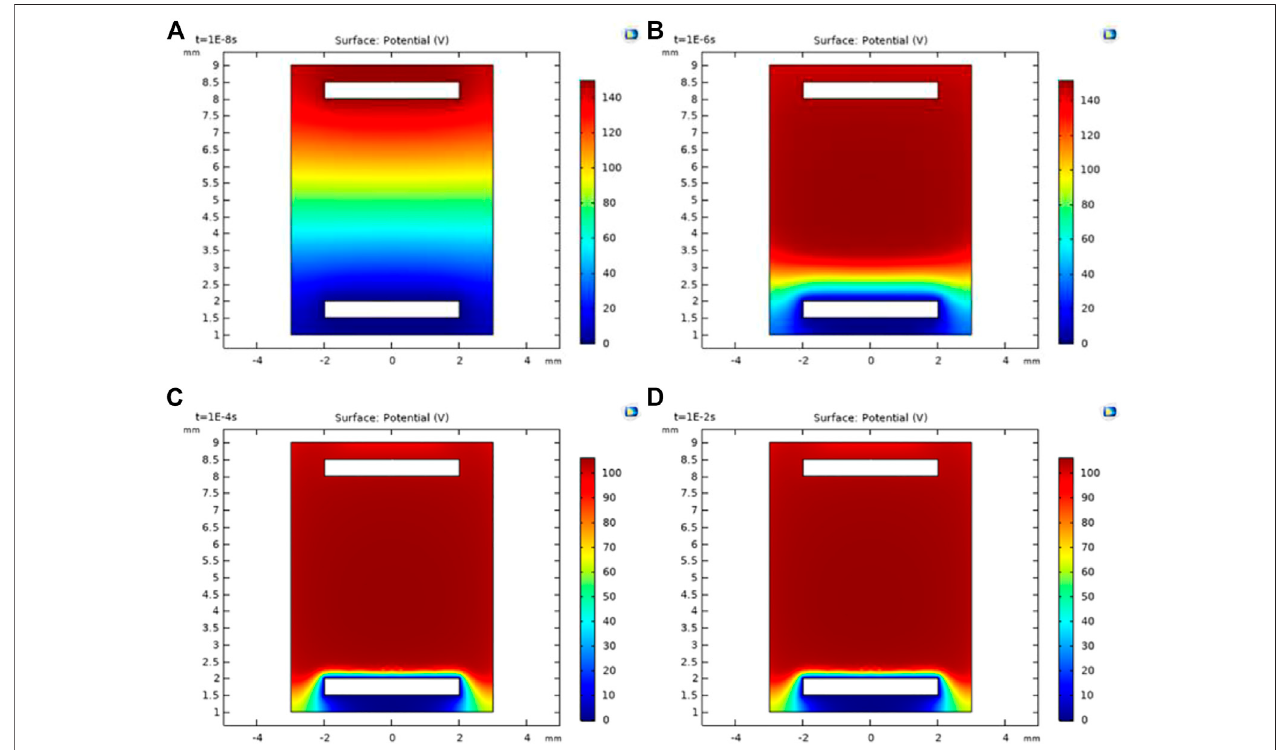
FIGURE 4 | Electric potential distribution at different times. (A) t (cid:2) 1 . 0 × 10 − 8 s; (B) t (cid:2) 1 . 0 × 10 − 6 s; (C) t (cid:2) 1 . 0 × 10 − 4 s; (D) t (cid:2) 1 . 0 × 10 − 2 s.